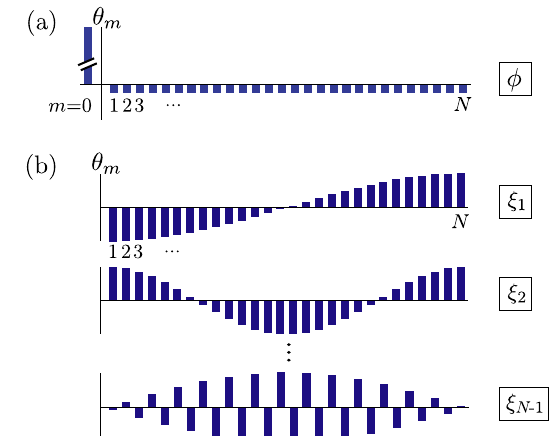
p 2 is the ladder operator